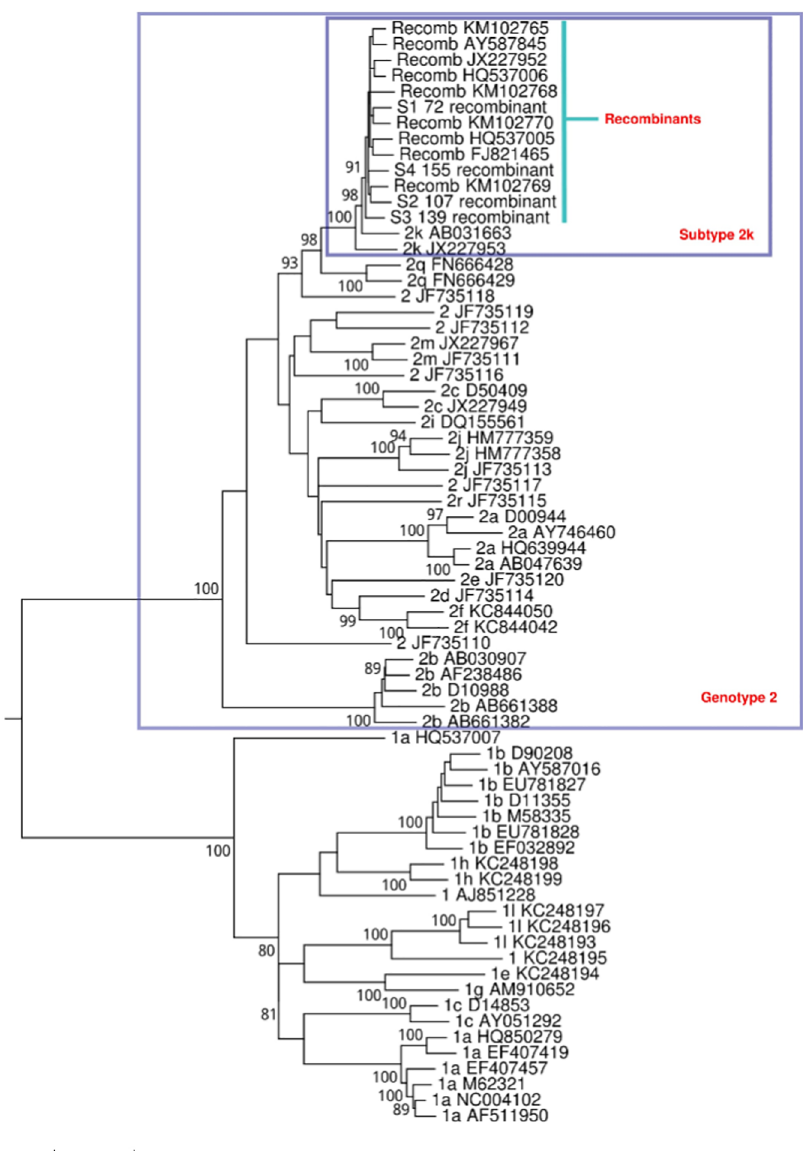
Fig 2. Phylogenetic analysis of the 5’UTR through NS1/p7. Maximum Likelihood tree constructed using MEGA 6.0 using the GTR model of evolution, incorporating assumed rate heterogeneity ( Γ , gamma) across sites and invariantsites (I). The four patient samples S1-S4 clusteredmost closely with genotype2 and subtype 2k.